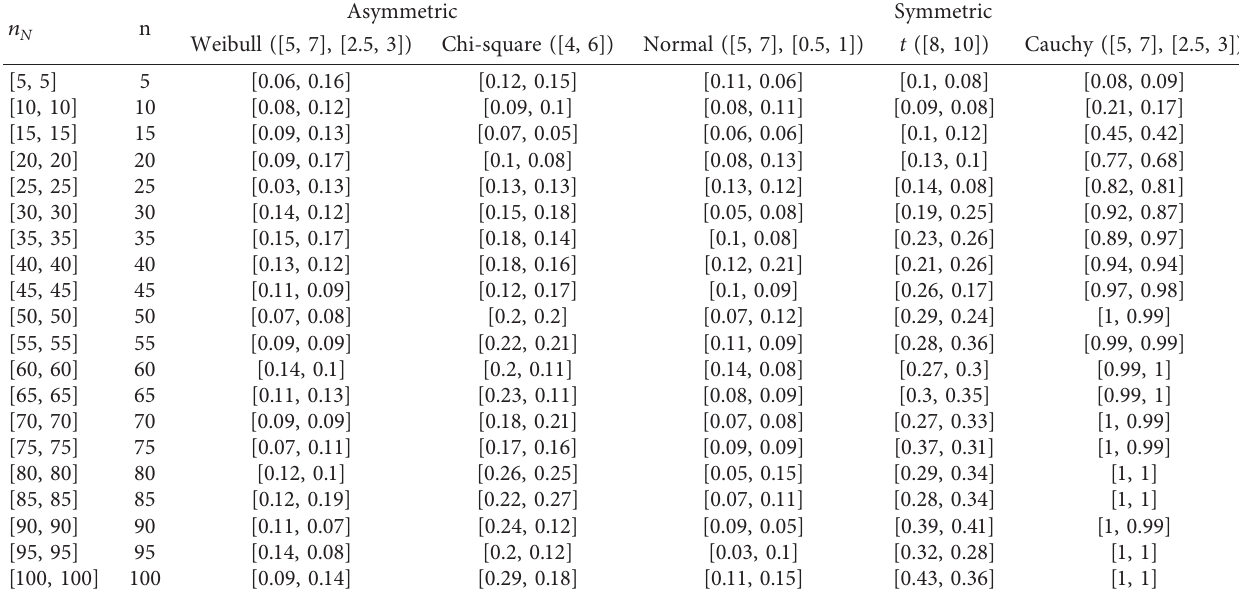
Table 4: Power of test for the proposed